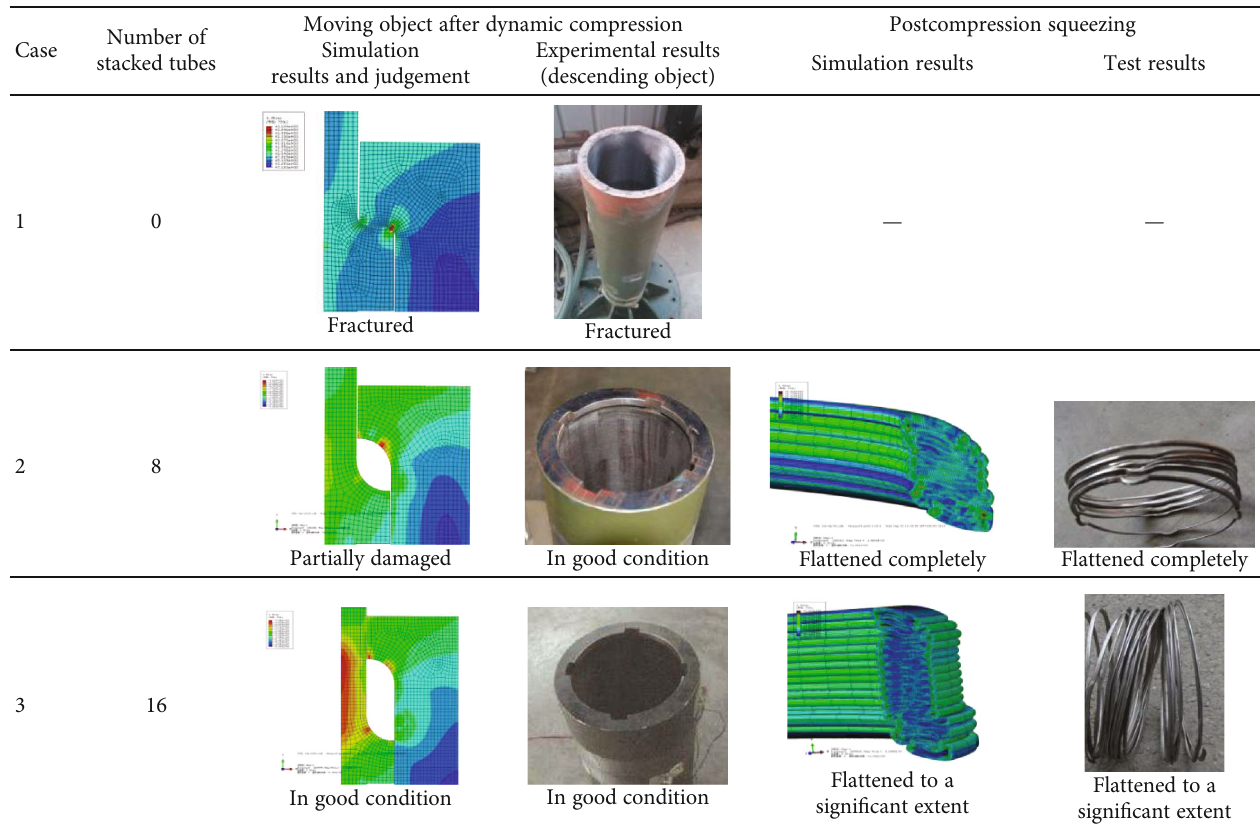
Table 6: Comparison of simulation and test